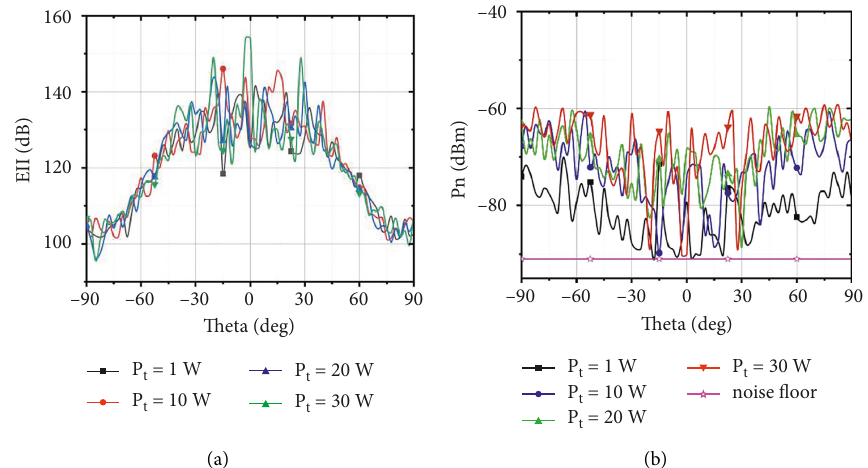
Figure 6: The performance of PSO optimizes beamforming at 10GHz. (a) The EII at different transmit power. (b) The P transmit power.